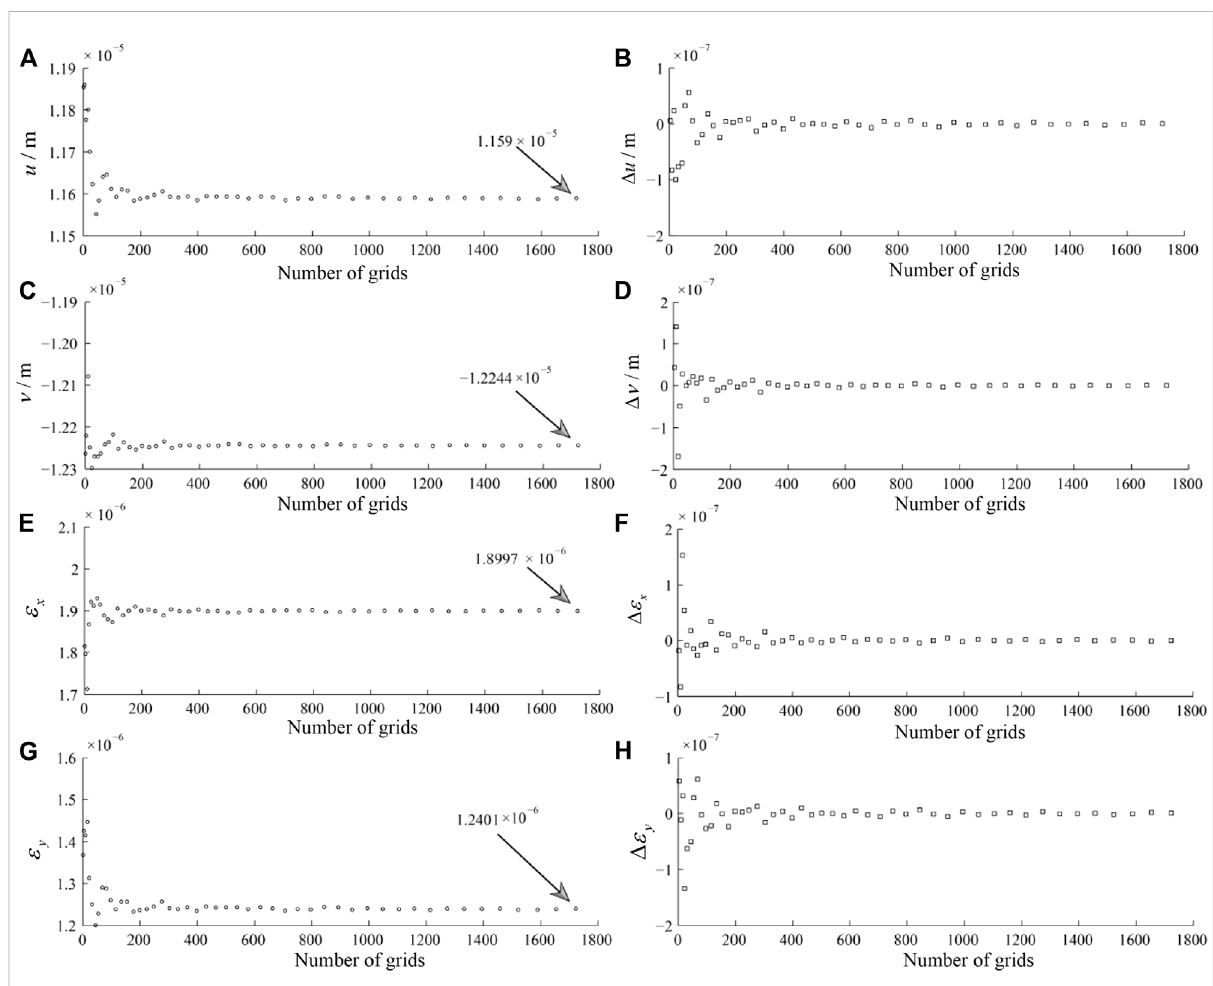
FIGURE 4 The relationship between the horizontal displacement and linear strain and the change of grid count n in the point of M(1.5 m, − 1.5 m, − 0.2 m) using the model of two dimensional irregular load (A) the relationship between displacement u and number of grids n; (C) the relationship between displacementv and number of grids n; (E) the relationshipbetweenlinear strain ε x and number ofgridsn; (G) therelationship between linear strain ε y and number of grids n; (B) , (D) , (F) , (H) are the fi rst-order differences of data of (A) , (C) , (E) , (G)